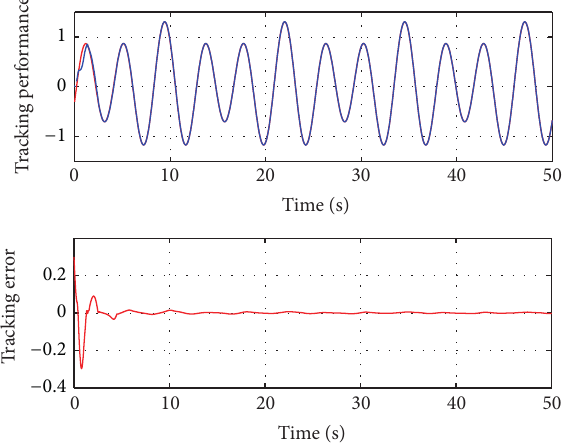
Figure 4: Tracking performance of the closed-loop system.